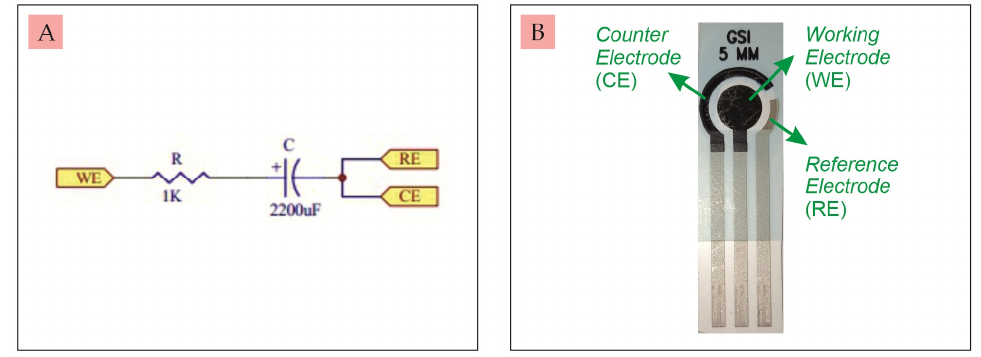
Figure 6. ( A ) Dummy circuit, ( B ) Commercial SPCE.